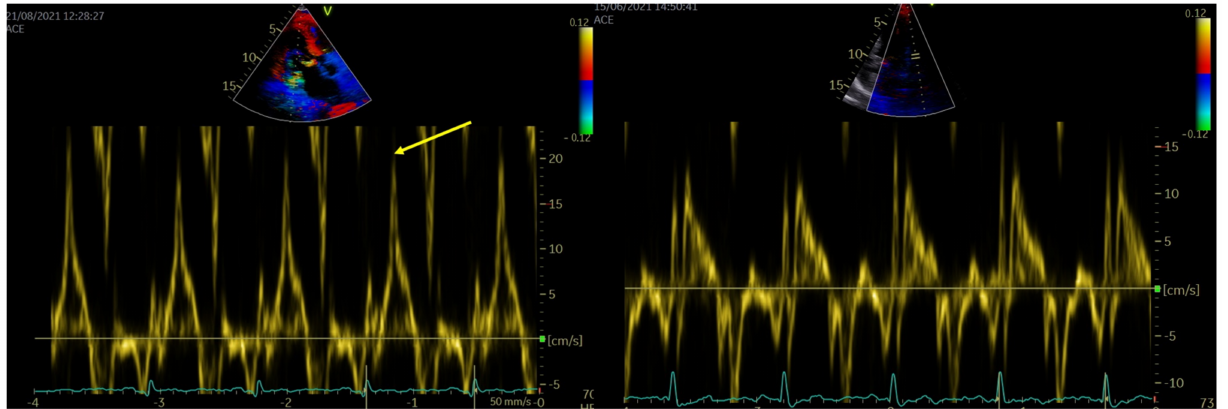
Figure 2. The presentation of the Pickelhaube sign (yellow arrow) as a spiked configuration of basolateral annular tissue Doppler imaging presentation (left panel). The presentation of S (cid:48) value of basolateral annular tissue Doppler imaging in patient without Pickelhaube sign (right panel).